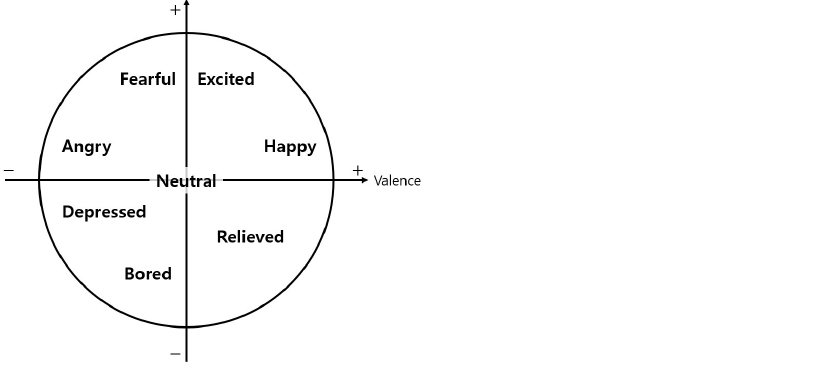
Figure 4. The correlations between the valence and arousal of defined eight